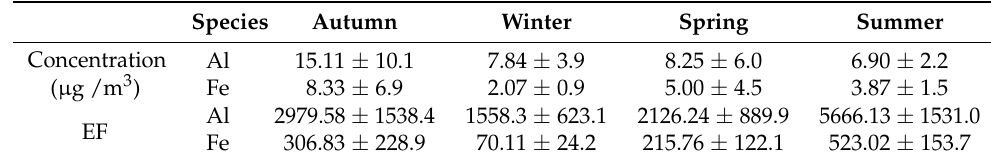
Figure 6. The seasonal changes of metal concentrations in Urumqi. Table 3. The seasonal Al and Fe concentrations and EF